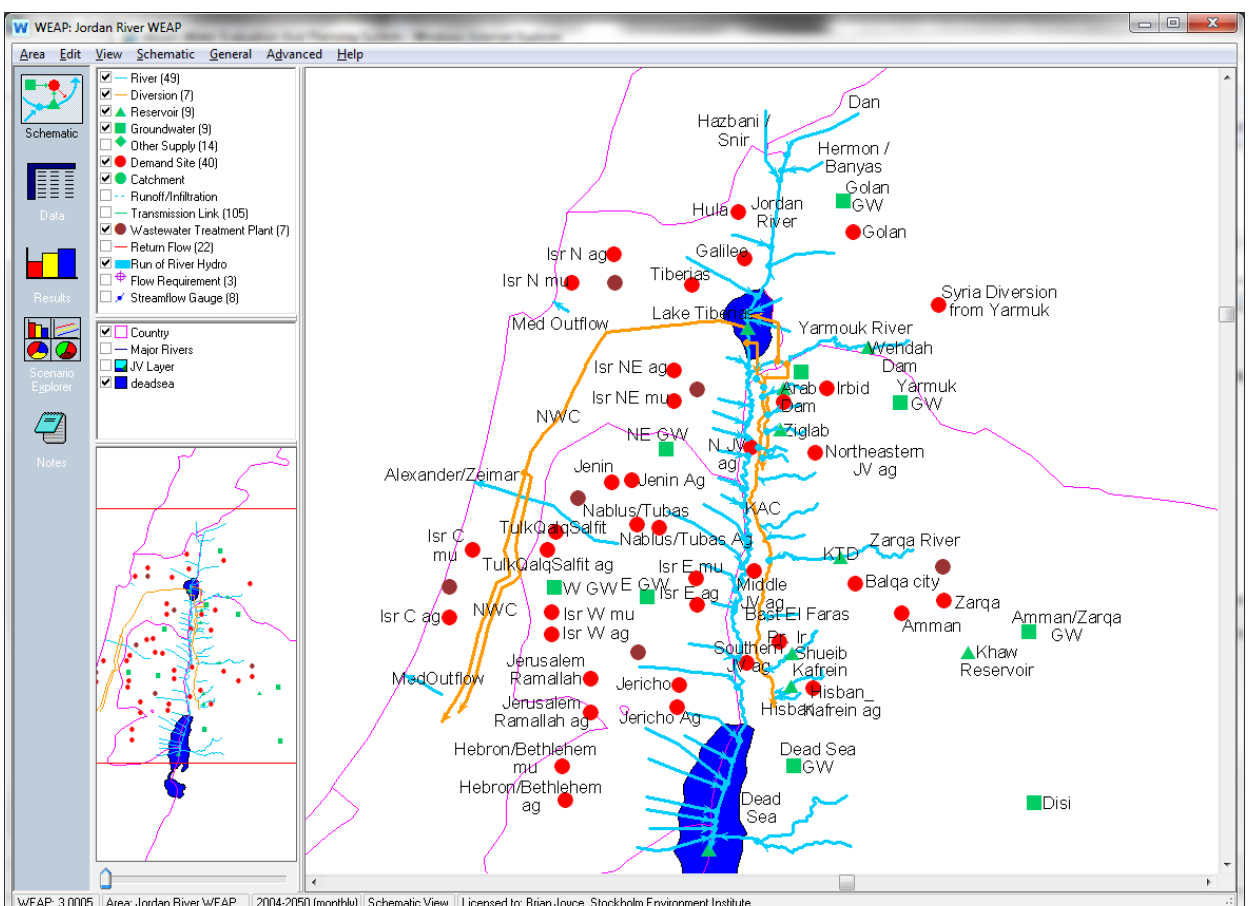
Figure 2. Conceptual representation/model schematic of the Jordan River water system in WEAP, with Lake Tiberias dividing the basin into an upper (upstream of the lake) and lower (downstream of the lake)